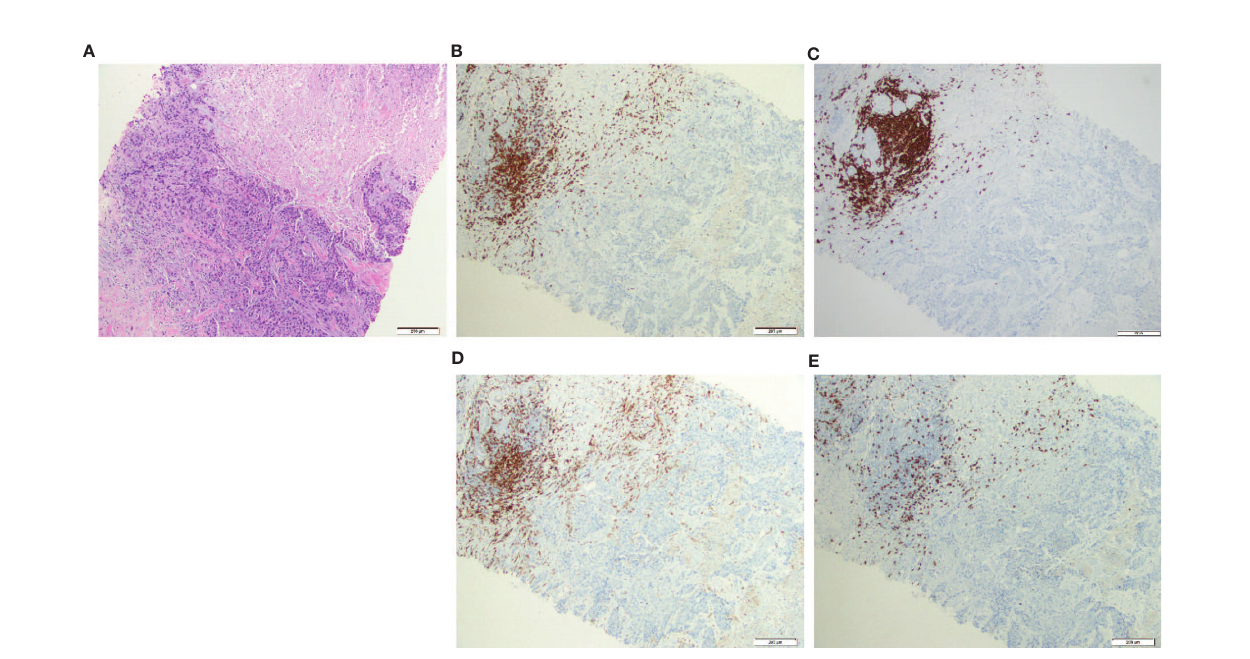
FIGURE 1 | CD3+ T cells (both CD4+ and CD8+) and CD20+ B cells were present and colocalized in the patient biopsy. Hematoxylin and eosin (HE) staining and immunohistochemistry (IHC) from the triple-negative breast cancer (TNBC) core biopsy realized after diagnosis. (A) Histological section stain from breast carcinoma (HE ×200); (B) CD3 IHC stain in breast carcinoma highlighted numerous CD3+ T cells in the in fi ltrating front of neoplasia (×200); (C) CD20 IHC stain showed a similar distribution of CD20+ B cells compared with CD3+ T lymphocytes (×200); (D) CD4 IHC stain revealed that most lymphocytes are CD4+ T cells (×200); (E) CD8 IHC stain highlighted less CD8+ T cells but nearest to the tumor in the in fi ltrating front